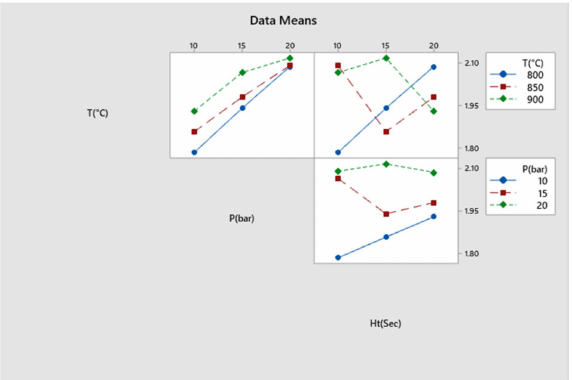
Figure 13. Interaction plots for the cooling rate at different experimental